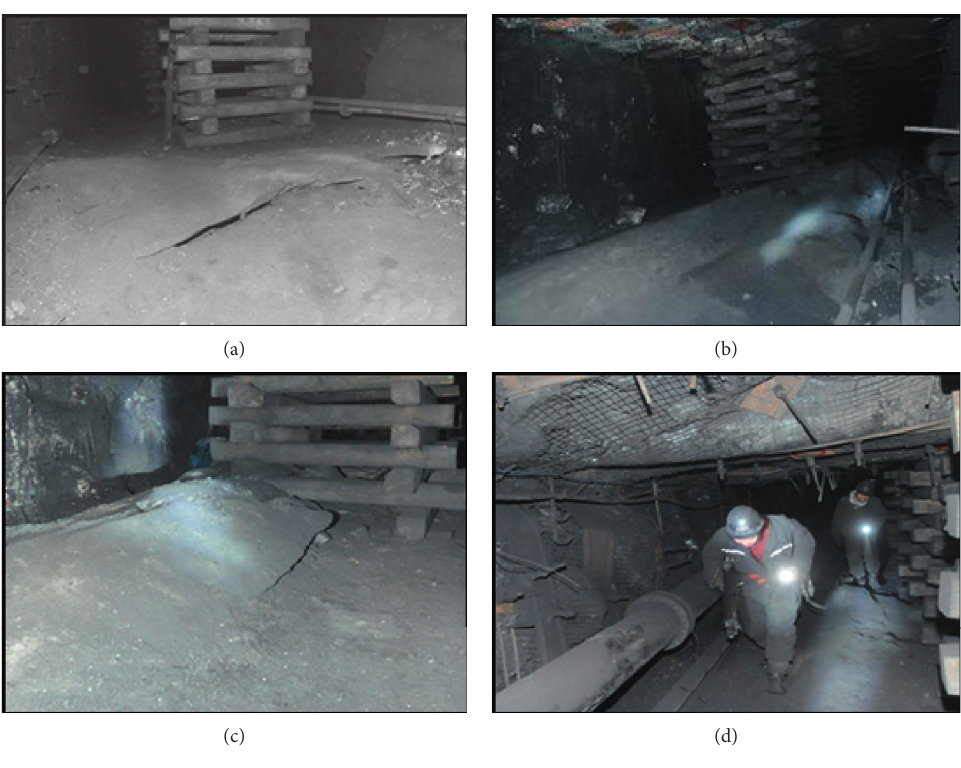
Figure 2: Situation of floor